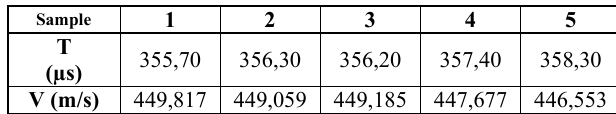
Table 10. The thermal experiments for the gypsum brick.